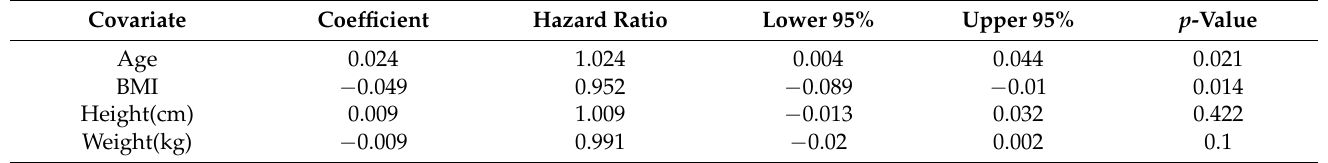
Table 2. Univariate Cox proportional-hazard models for clinical